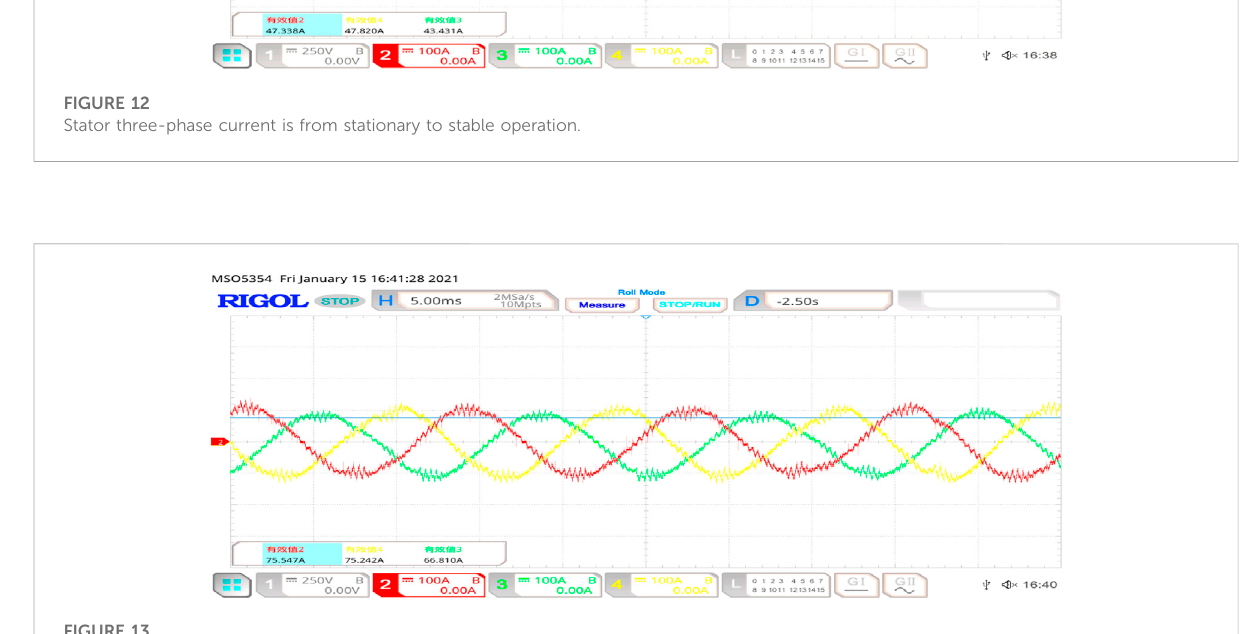
FIGURE 13 Stator three-phase current is under steady-state operation.